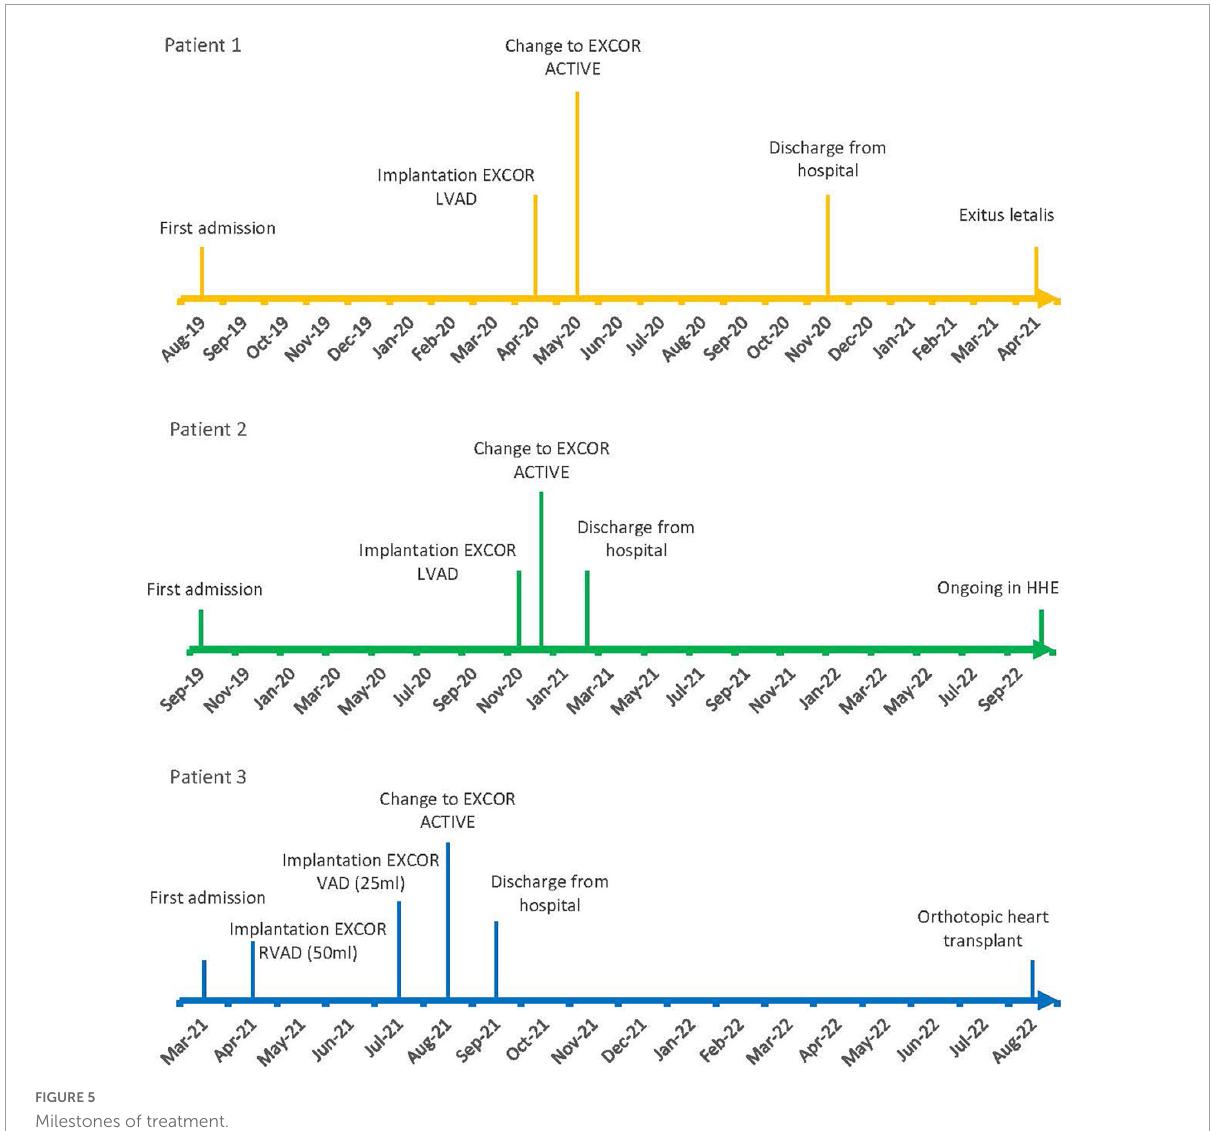
FIGURE5 Milestones of